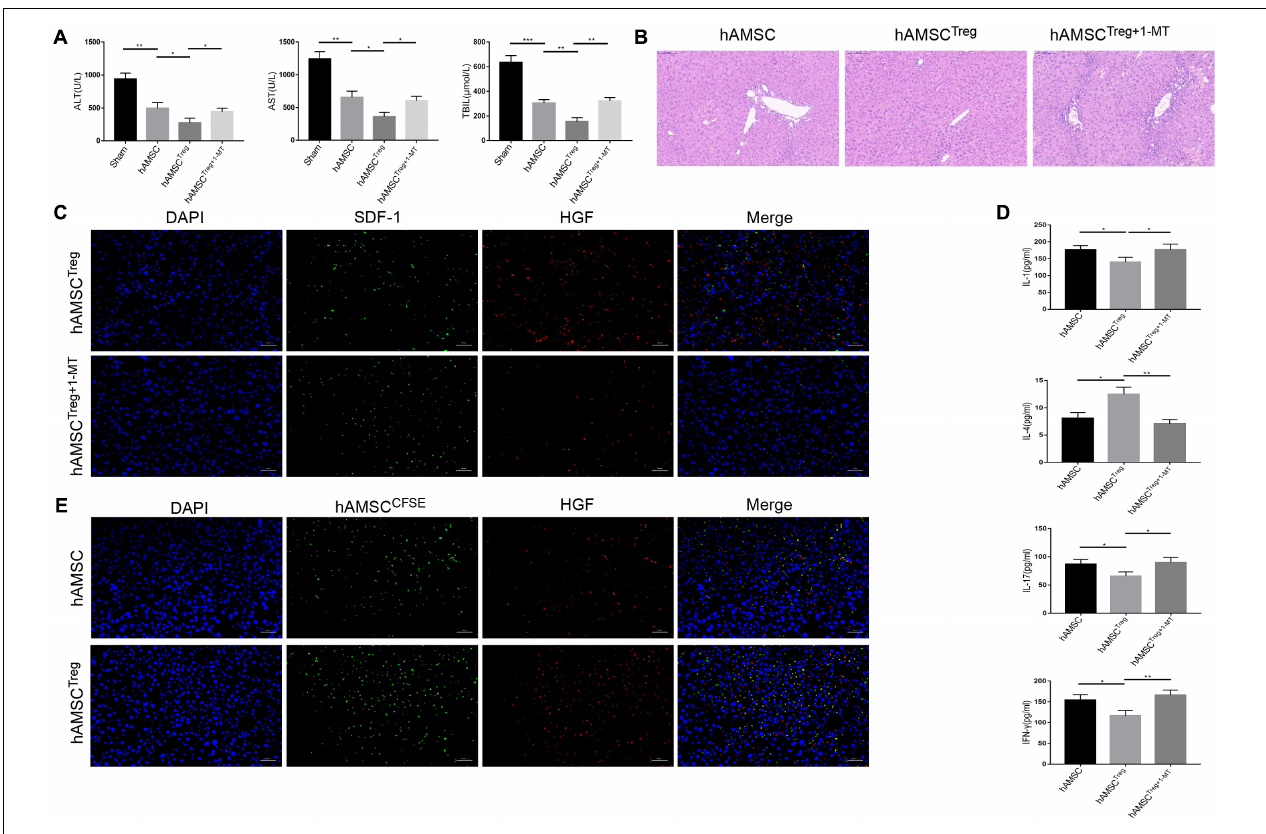
FIGURE 6 | PBS, hAMSC, hAMSC Treg , and hAMSC Treg + 1 − MT were injected into mice through the tail vein, respectively. (A) Level of ALT, AST, and TBIL of four groups. (B) Representative images of liver tissue [hematoxylin and eosin (HE) staining] by light microscopy in hAMSC, hAMSC Treg , and hAMSC Treg + 1 − MT group. (C) Representative fluorescent images for SDF-1 and HGF in hAMSC Treg and hAMSC Treg + 1 − MT group were visualized by fluorescence microscopy, and DAPI was used to mark nuclei. (D) Level of IL-1, IL-4, IL-17, and IFN- γ in hAMSC, hAMSC Treg , and hAMSC Treg + 1 − MT group. (E) Representative fluorescent images for hAMSC and HGF were visualized by fluorescence microscopy, and DAPI was used to mark nuclei. The result is representative of three independent experiments. Data were mean ± SD of three independent experiments. * p < 0.05, ** p < 0.01, *** p <